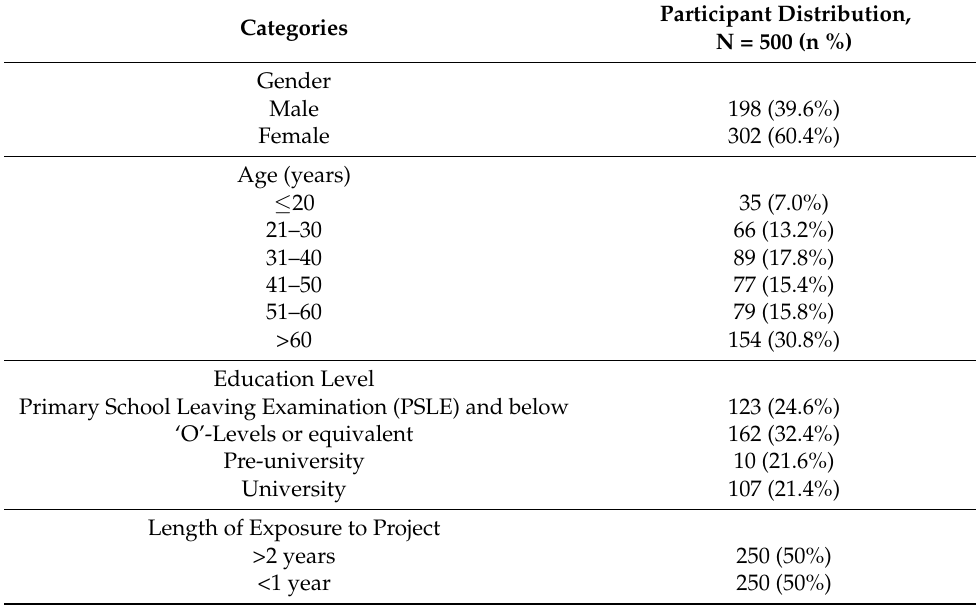
Table 2. Socio-demographics of participants (N =